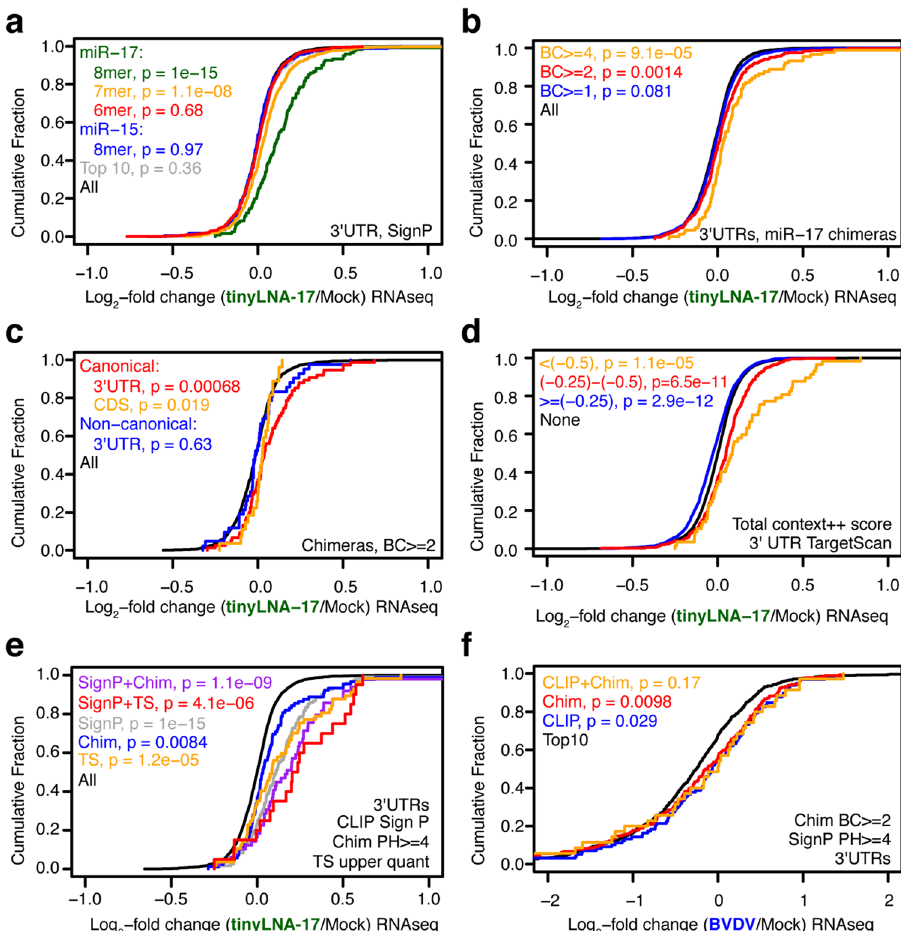
Figure 3. Comparison of experimental and bioinformatic predictors of miR-17 regulation. (a – e) Cumulative density function (CDF) of the log 2 -fold change in mRNA abundance between tinyLNA-17 and mock treated MDBK cells is shown using grouping of mRNAs by ( a ) presence of miRNA seed sites in 3 ′ UTR significant AGO-CLIP peaks, ( b ) BC of miR-17 chimeras in 3 ′ UTRs, ( c ) canonical or non-canonical miR-17 chimeras in CDS and 3 ′ UTRs, ( d ) 3 ′ UTR TargetScan7 context ++ score for miR-17, or ( e ) combining the experimental and bioinformatic predictors. (f) CDF plots of the log 2 -fold change in mRNA abundance between BVDV(cp) infected and mock treated MDBK cells grouping mRNAs by presence of significant AGO-CLIP peaks or miR-17 chimeras on 3 ′ UTRs. Two-sided K-S test p-values are